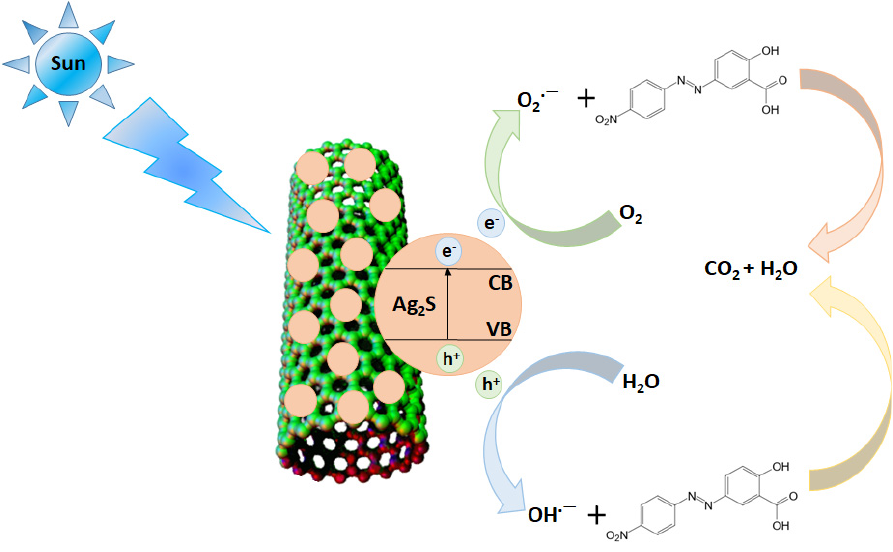
Figure 15. A possible mechanism for the degradation of alizarin yellow R in the presence of CNTs ‐ Ag 2 S under exposure to sunlight.